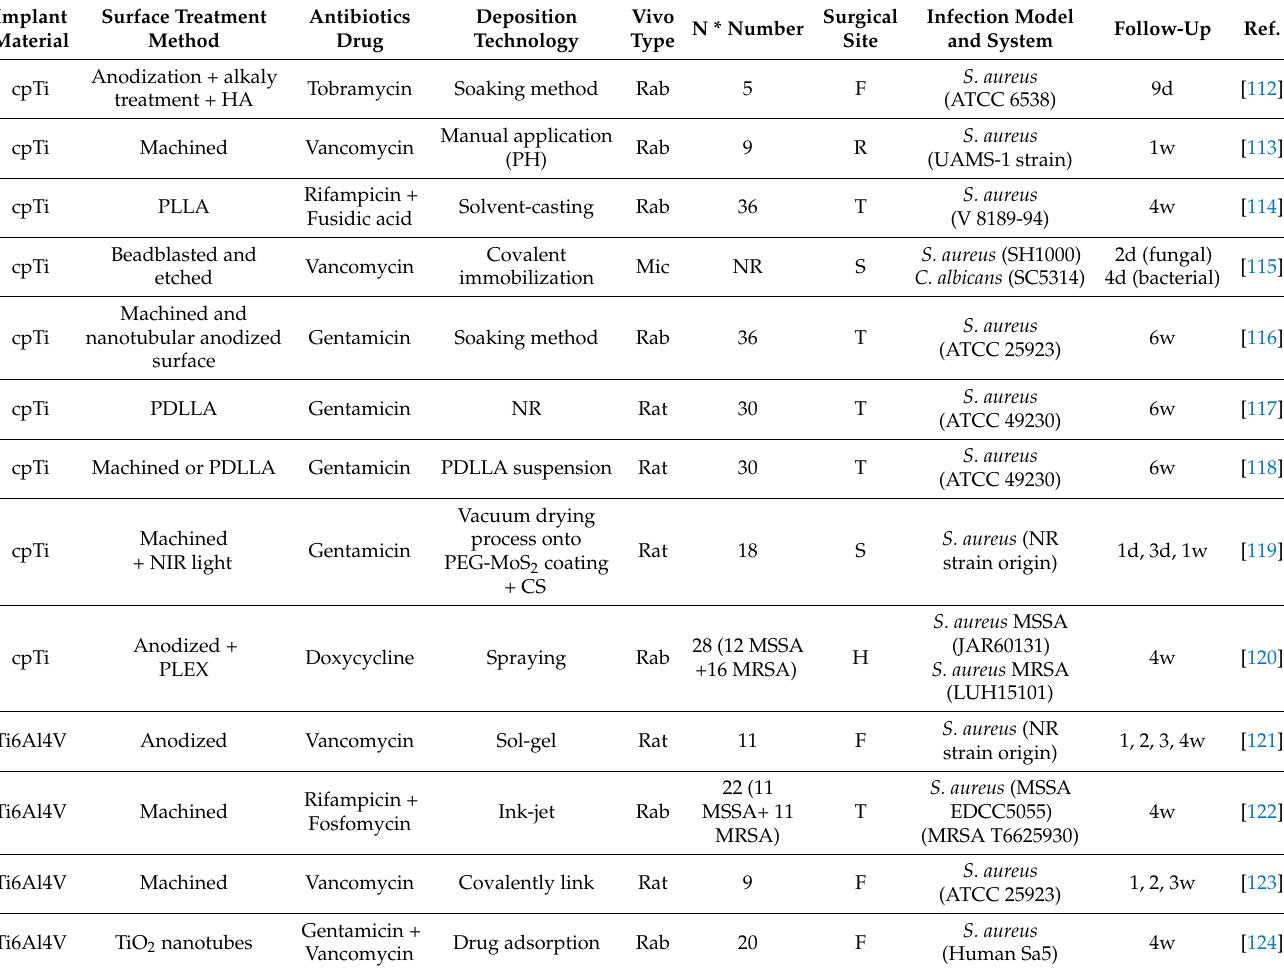
Table 1. In vivo studies of various drug coated metallic implants for bone tissue engineering